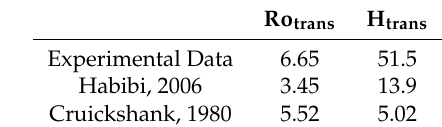
Table 1. Transition values with respect to Roshko numbers and non-dimensional heights as plotted in Figure 11.